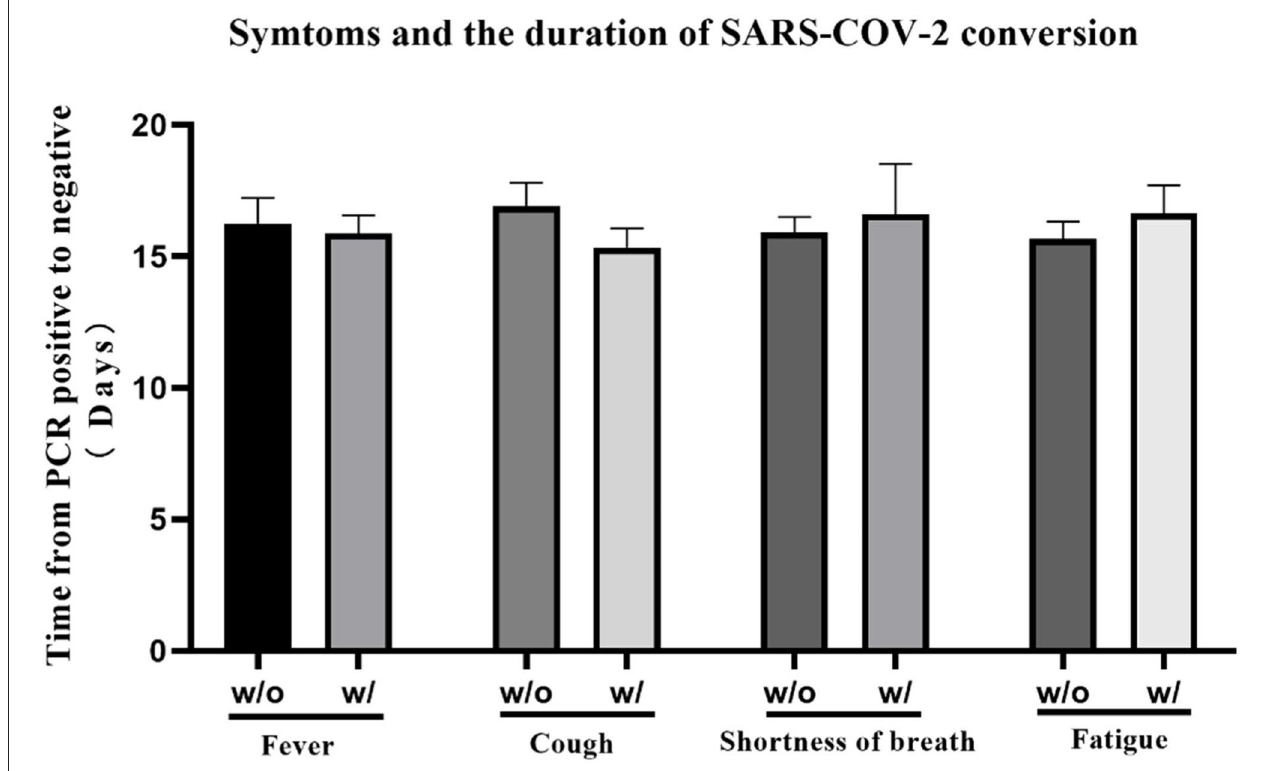
FIGURE 1 | The time for real-time PCR (rtPCR) result transition from positive to negative was compared between patients with or without specific symptom at the onset. The average time of patients with/without fever was 16.24 ± 0.985/15.88 ± 0.696, p = 0.545; the average time of patients with/without cough was 16.92 ± 0.882/15.33 ± 0.738, p = 0.064; the average time of patients with/without shortness of breath was 15.91 ± 0.589/16.60 ± 1.925, p = 0.682; the average time of patients with/without fatigue was 15.67 ± 0.659/16.63 ± 1.074, p = 0.770. No significant differences were observed among the different study groups.